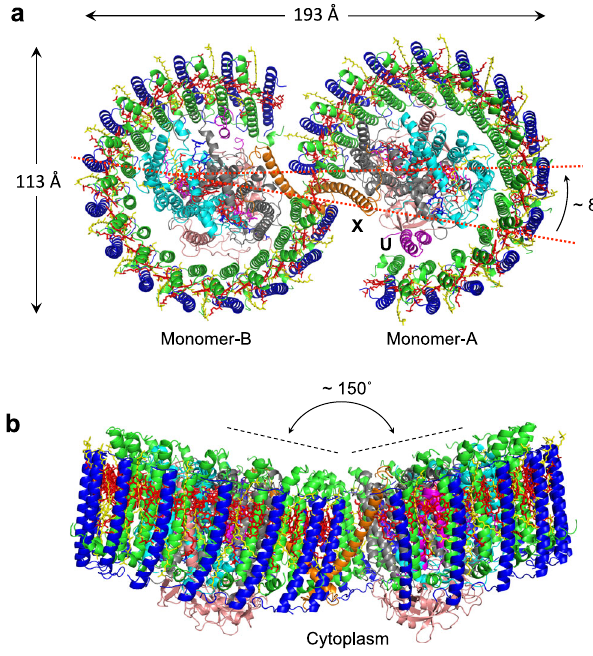
Fig. 1 Structure overview of the dimeric LH1 – RC complex from Rba. sphaeroides IL106. a Top view from the periplasmic side of the membrane with PufX (orange) and protein-U (magenta) in monomer A indicated by their chain ID: X and U, respectively. b Side view of the core complex parallel to the membrane plane with the H-subunits (salmon) at the bottom. Color scheme: LH1- α , green; LH1- β , blue; RC-L, black; RC-M, cyan; BChl a , red sticks; spheroidenes, yellow sticks; BPhe a , magenta